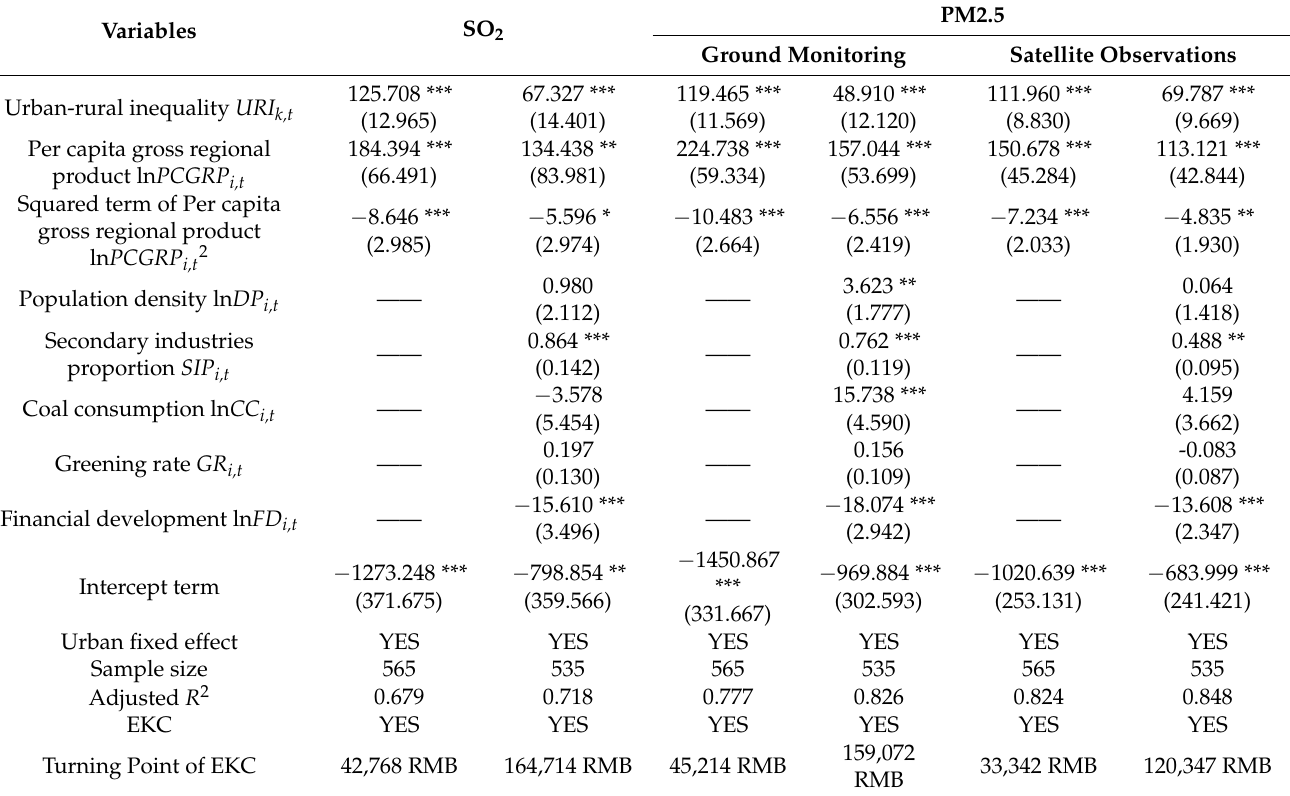
Table 6. Regression analysis for EKC hypothesis: SO 2 and